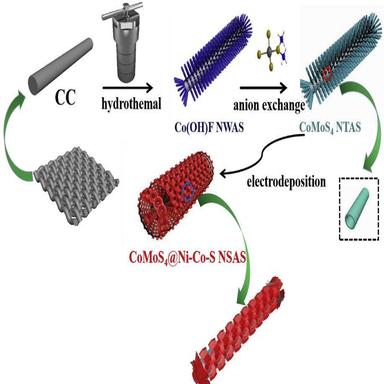
Schematic illustration of the fabrication of Hierarchical core-shell hollow CoMoS4@NieCoeS nanotubes electrode.